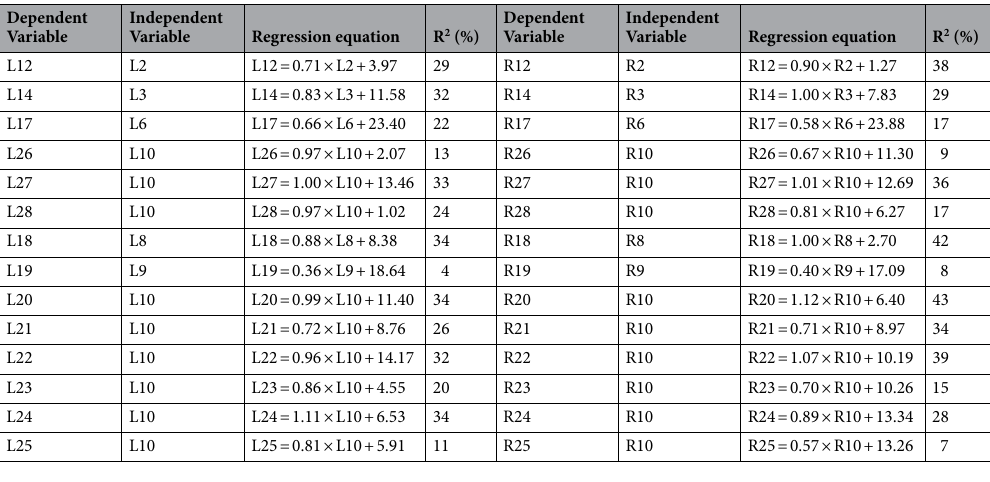
Table 2. Regression equations developed from the measurements in females. The coefficient of determination is R 2 . All regression equations are shown in Supplementary Table S4. ‘L’ stands for left, and ‘R’ stands for right in each measurement.